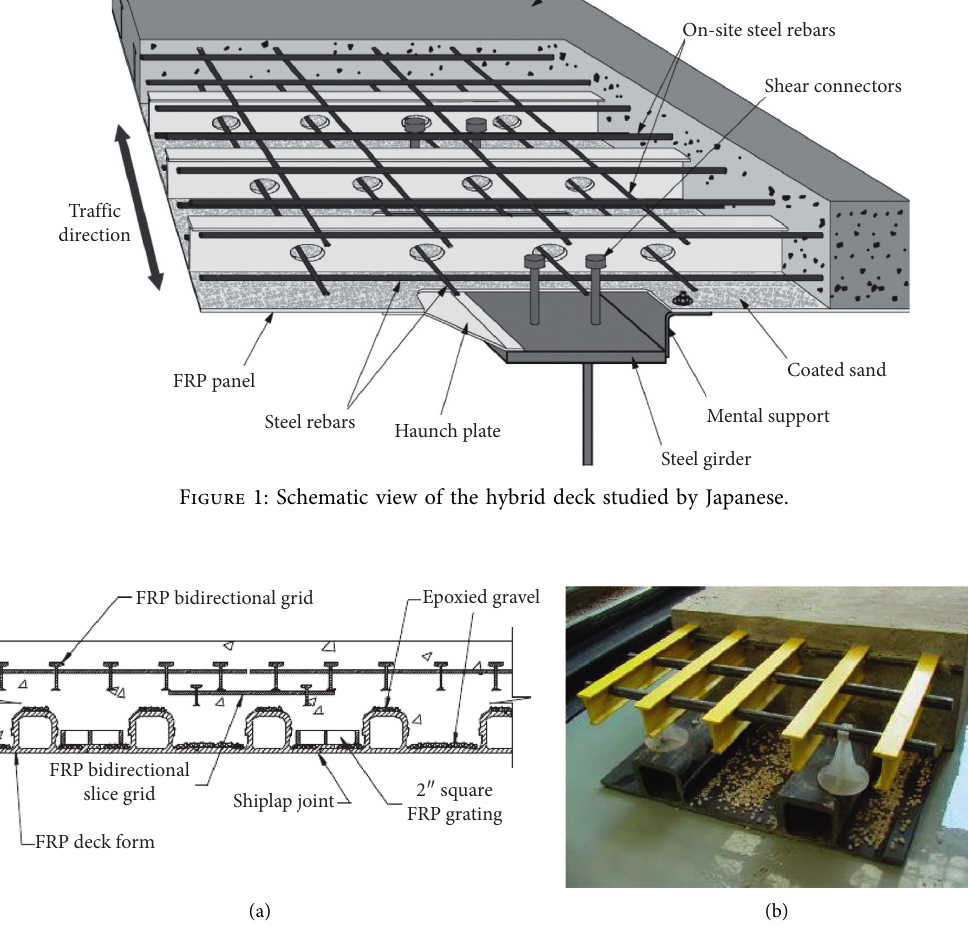
Figure 2: The layout of the hybrid deck studied by Dieter. (a) Cross-section layout. (b) Configuration detail.